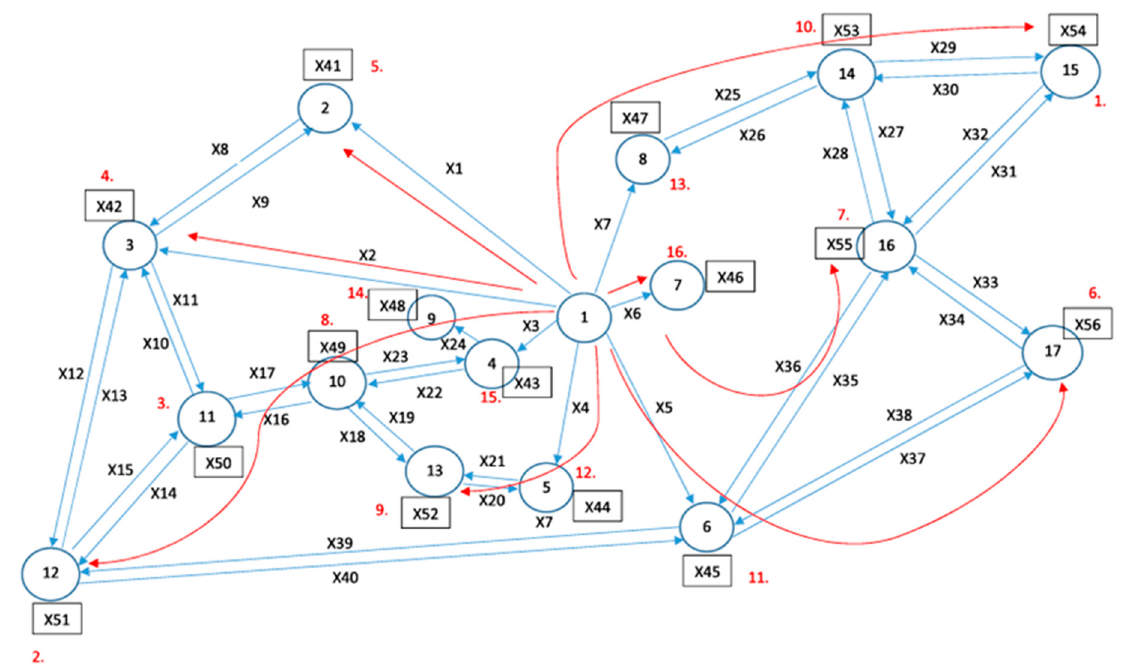
Figure 3. Simplified electricity network in a small town (blue lines); red lines show the flow pathways in the solution, when the flow costs in the edges are proportional to their actual lengths and the costs of unmet demands are the same for all nodes. The red numbers show the sequence in which the nodes stop to receive electrical power as the supply at Node 1 gradually decreases.